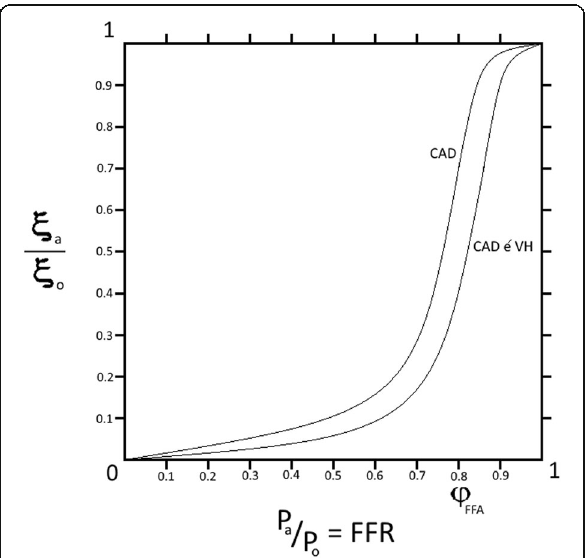
Fig. 1 A graphical representation of the relation between the ratio of Fig. 2 A graphical representation of the relation between the ratio of the perfusion of myocardial tissue supplied by a stenotic epicardial the perfusion of myocardial tissue supplied by a stenotic epicardial coronary ξ a to the perfusion in case of hypothetical absence of stenosis coronary ξ a to the perfusion in case of hypothetical absence of stenosis α e ) a to the ξ ξ 0 and the ratio of the radius of the said stenotic artery ( 0 , and FFR which is the ratio of the pressure distal to the stenosis radius in case of hypothetical absence of stenosis ( α e ) 0 . Both ratios are the pressure proximal to the stenosis P 0 . Both ratios are presented by presented by absolute numbers. In isolated CAD, the directly absolute numbers. In isolated CAD, the directly proportional relationship proportional relationship is represented by a sigmoid-shaped curve, is represented by a sigmoid-shaped curve, wherein the perfusion of wherein the perfusion of myocardial tissue supplied by the said stenotic myocardial tissue supplied by the said stenotic epicardial coronary ξ a epicardial coronary ξ a collapses relatively at a critical stenotic value ϕ α . collapses relatively at a critical stenotic value ϕ FFR . Comorbid CAD and Comorbid CAD and ventricular hypertrophy shift the curve to the right ventricular hypertrophy shift the curve to the right leading to an increase leading to an increase in the critical stenotic value ϕ α in the critical stenotic value ϕ